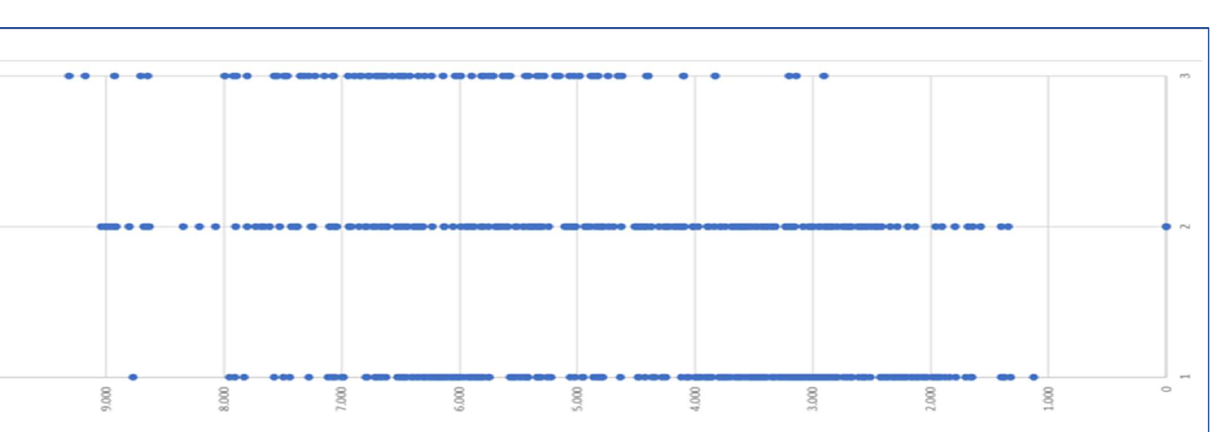
Table 5. Cluster membership within observations of the categories.